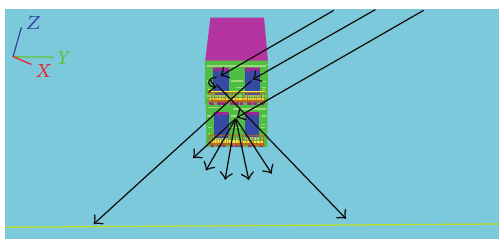
Figure 2: Geometrical configuration of the presented simulation.